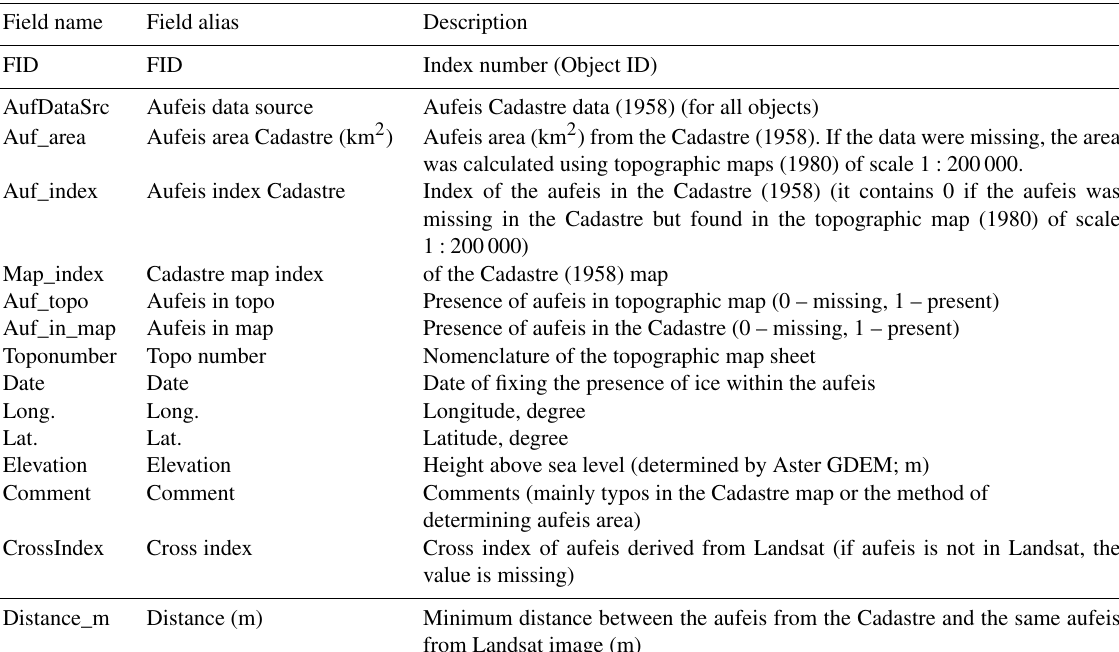
Table 1. The structure of the GIS database of aufeis using Cadastre (1958).